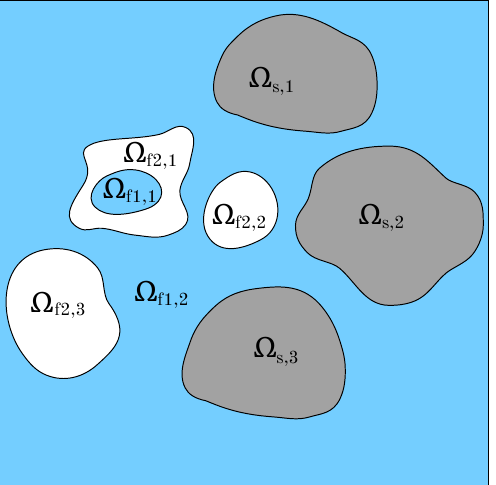
Figure 1. Schematics of the computational domain containing fluids 1 (blue) and 2 (white) in Ω f and Ω f , respectively, and solids in Ω s , k 2 , k